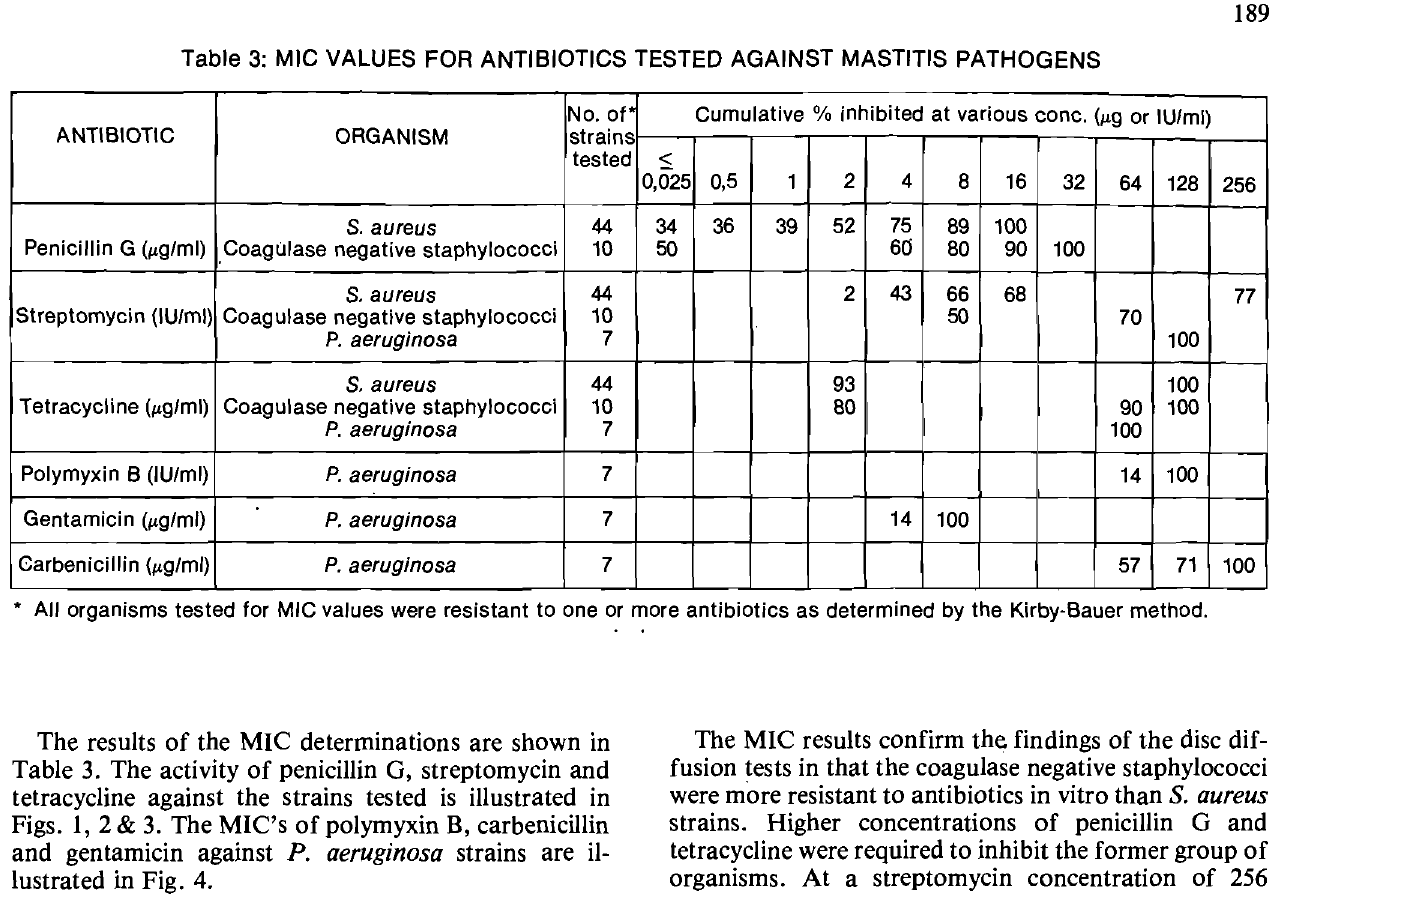
Table 3: MIC VALUES FOR ANTIBIOTICS TESTED AGAINST MASTITIS PATHOGENS No. of